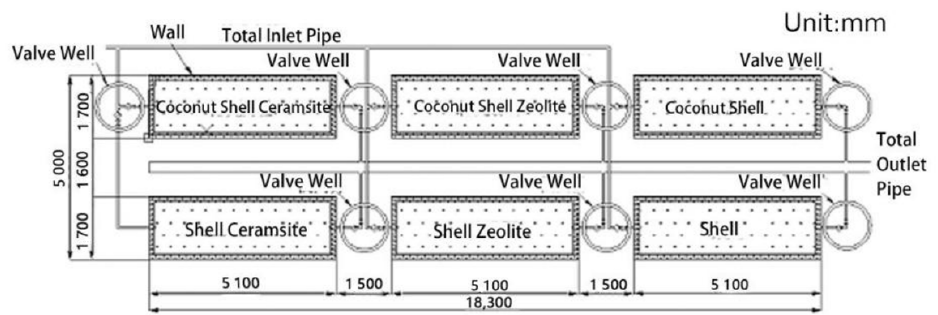
Figure 1. The plan of the constructed wetland.